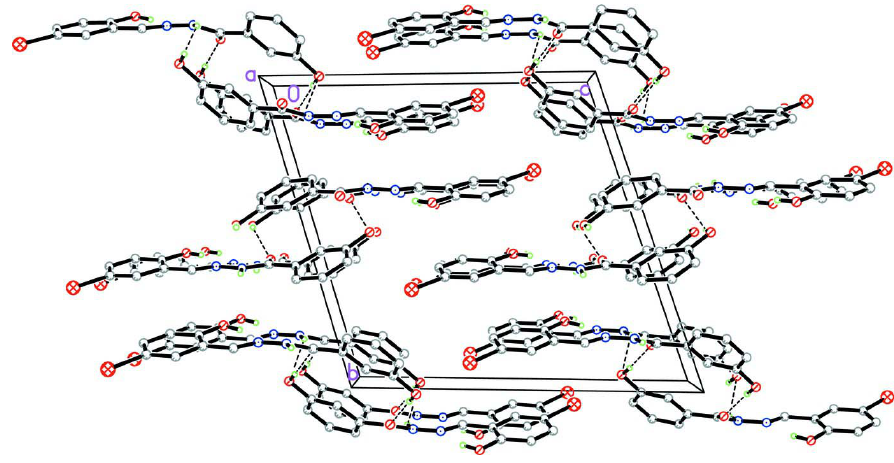
Figure 2 Molecular packing of the title compound. Hydrogen atoms not involved in intermolecular hydrogen bonds (dashed lines) are omitted for